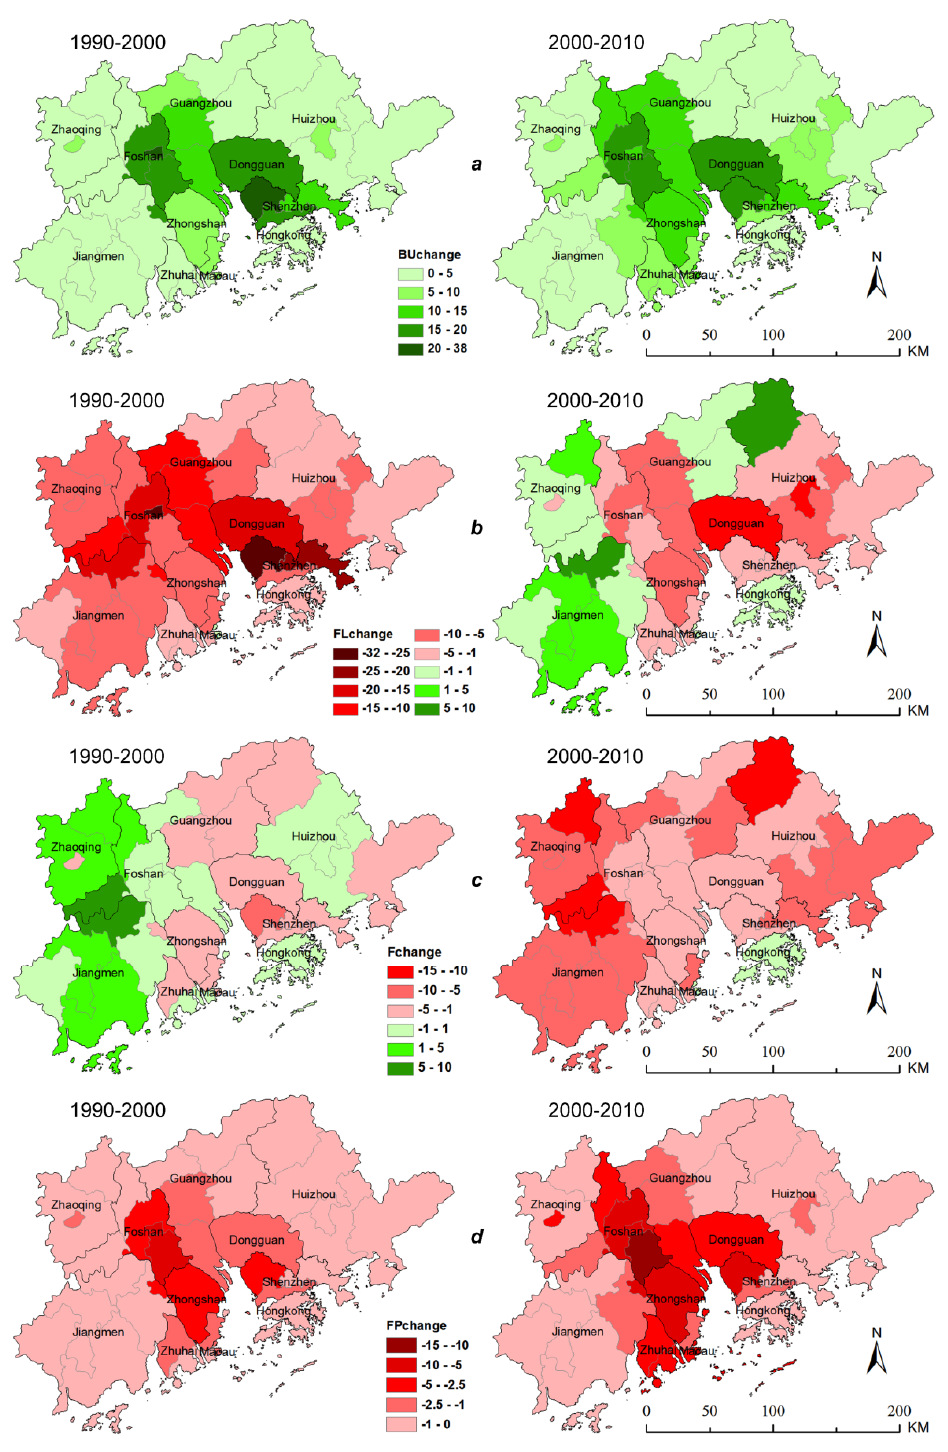
Figure 5. Relative land use change at county level in ( a ) built up; ( b ) farmland; ( c ) forest; and ( d )